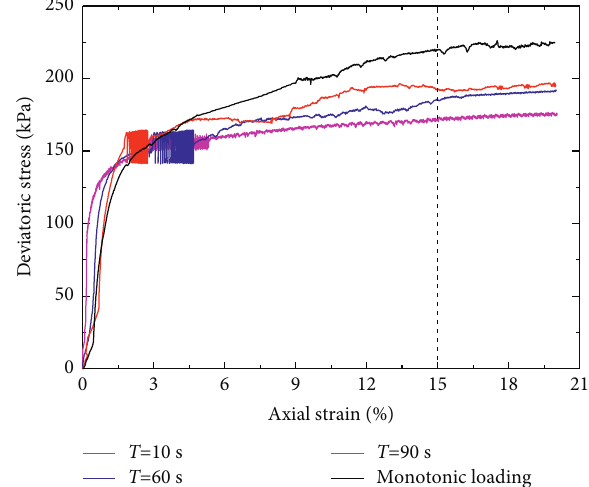
Figure 10: Curve deviator stress versus axial strain at a constant confining stress of 100kPa under N �